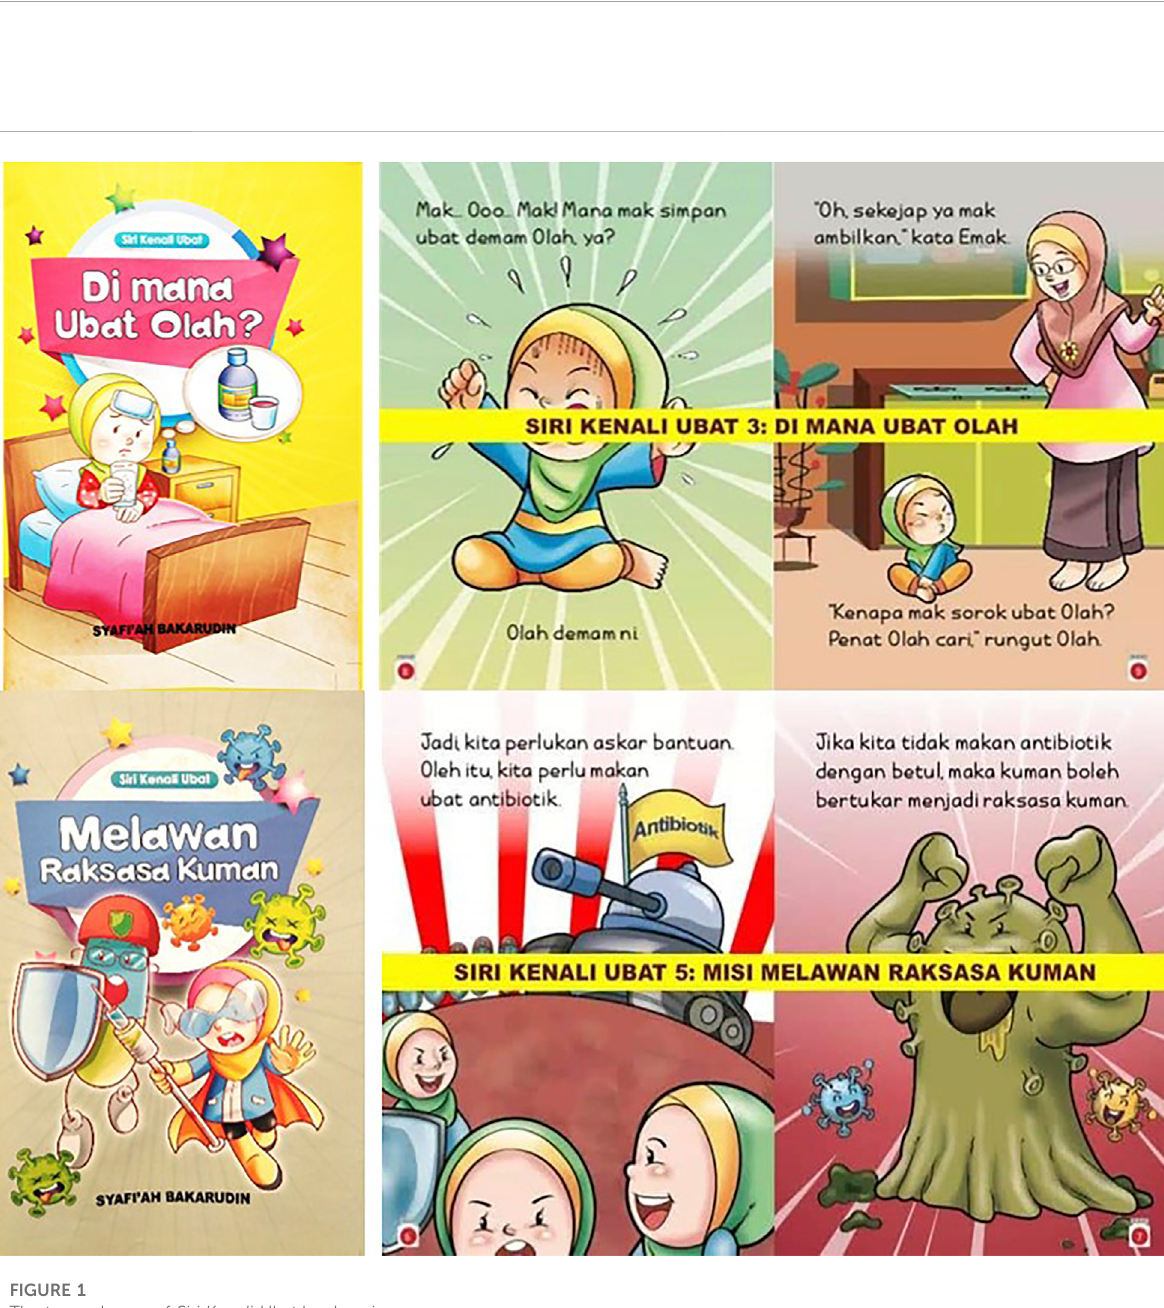
FIGURE 1 The two volumes of Siri Kenali Ubat book